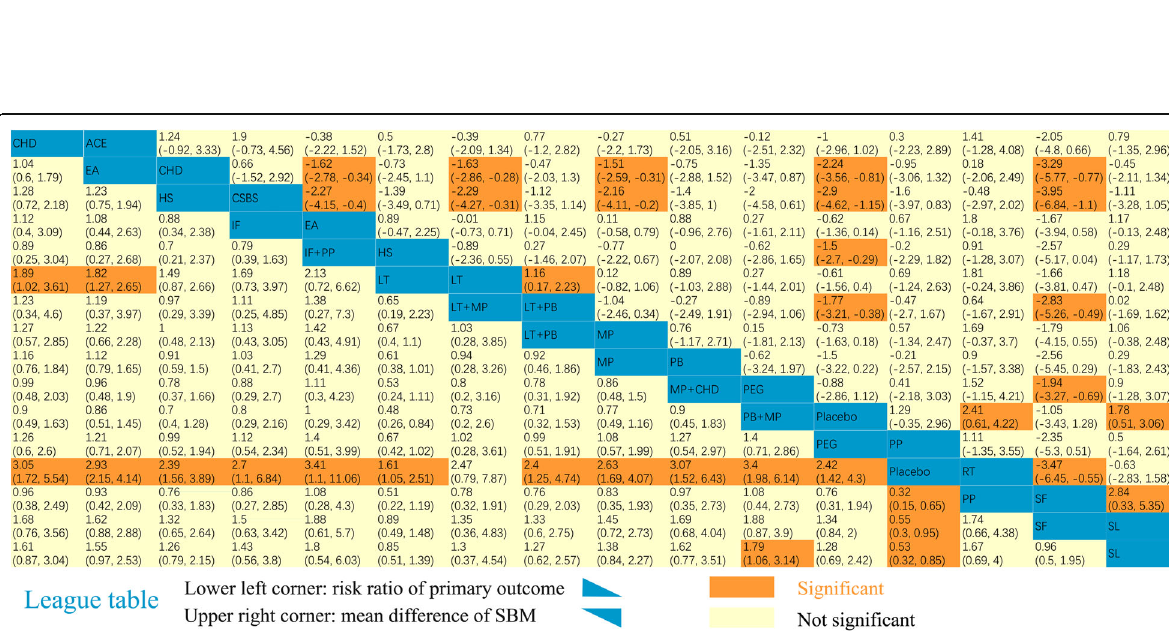
Fig. 6 League table of network estimates. Lower left corner: The risk ratio of the responder rateUpper right corner: The mean difference of the SBM